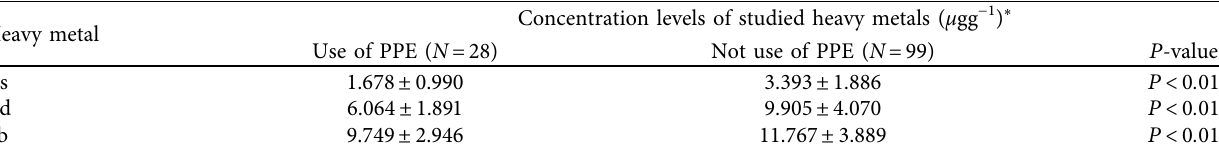
Table 8: Concentration levels of As, Cd, and Pb in fingernail of participating farmers according to PPE usage. Heavy